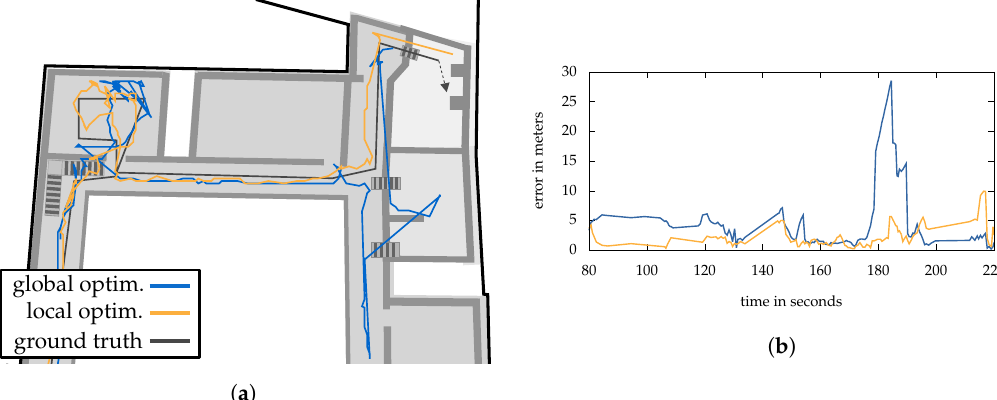
Figure 9. Error development over time of a single particle filter run of walk 0. Between 10s and 24s the Wi-Fi signal was highly attenuated, causing the system to get stuck and producing high errors. Both, the simple and the D KL anti-impoverishment method are able to recover early. However, between 65s and 74s the simple method produces high errors due to the high random factor involved.